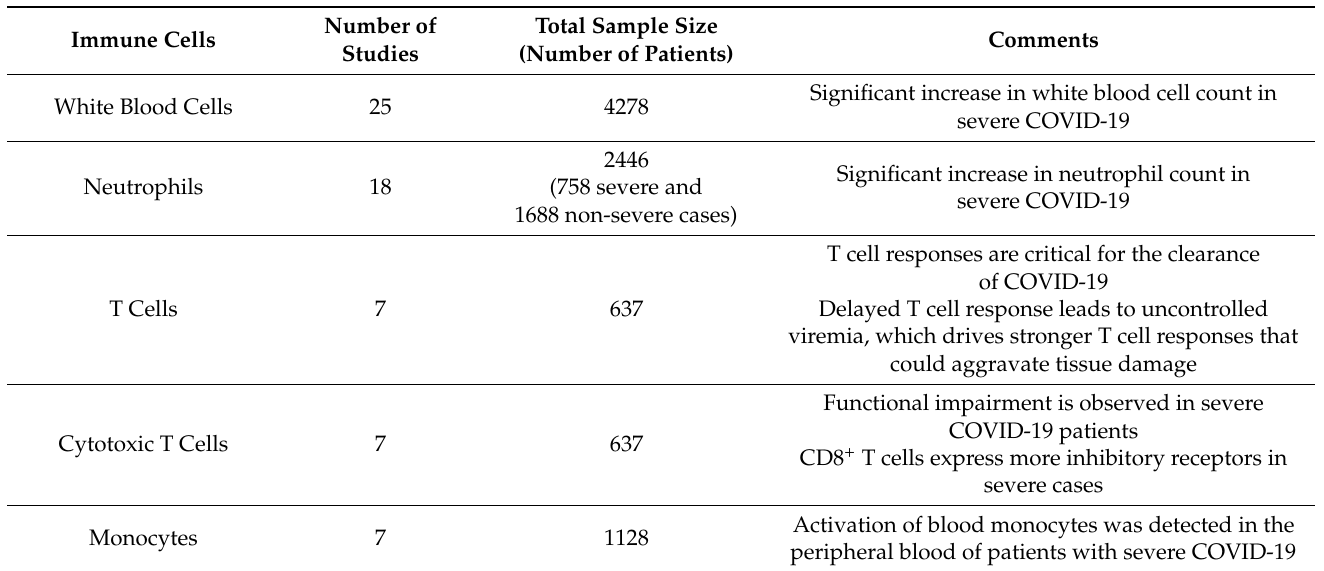
Table 2. Correlation between immune cells and patients with severe COVID-19 (Reference